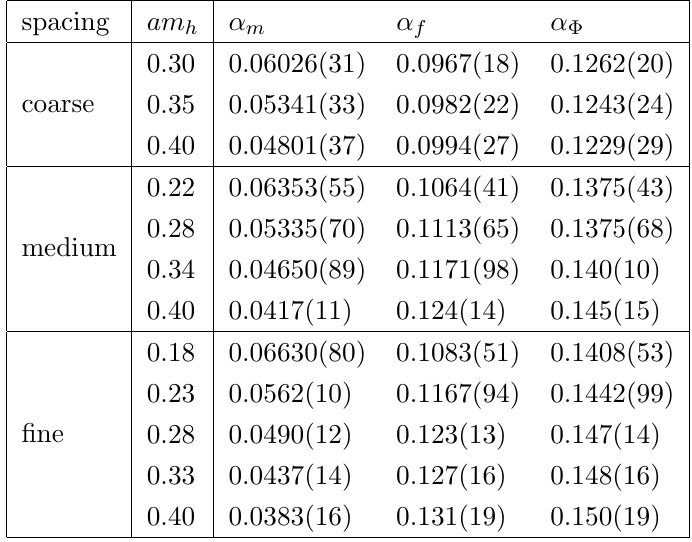
Table 8 . Values of (cid:11) for the three observables ( O = m D determined can be found in the